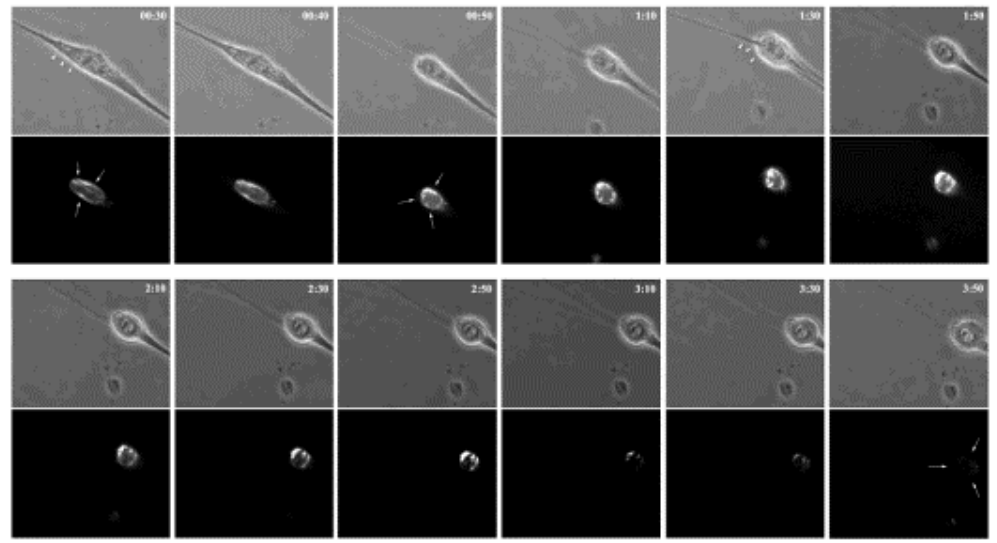
Fig. 1. Time-lapse study of beta-amyloid induced apoptosis in a human SH-SY5Y neuroblastoma cell line expressing POM121-GFP. The cells were incubated at 37° C in cell culture medium containing 25 µM beta-amyloid (25-35). Every 10 min a phase contrast (upper panels) and a fluorescence (lower panels) micrograph were taken. The time after addition of the peptide is indicated in the upper right corner of each phase contrast micrograph. Note the change in morphology (arrowheads) concomitant with the disappearance of the GFP fluorescence (arrows) in the periphery of the